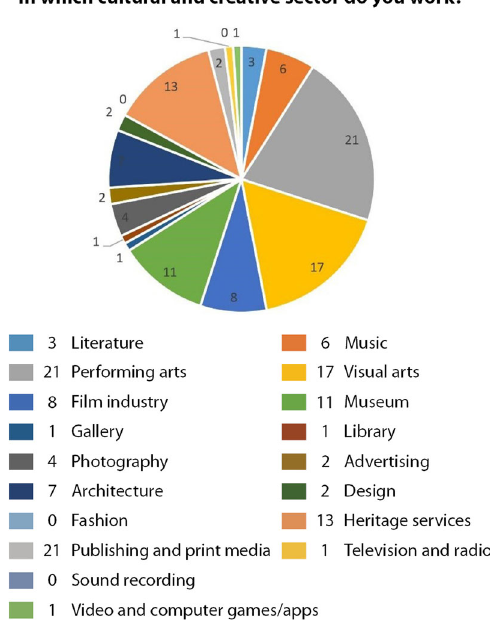
Fig. 6 respondents ’ professional sectors distribution (Source: